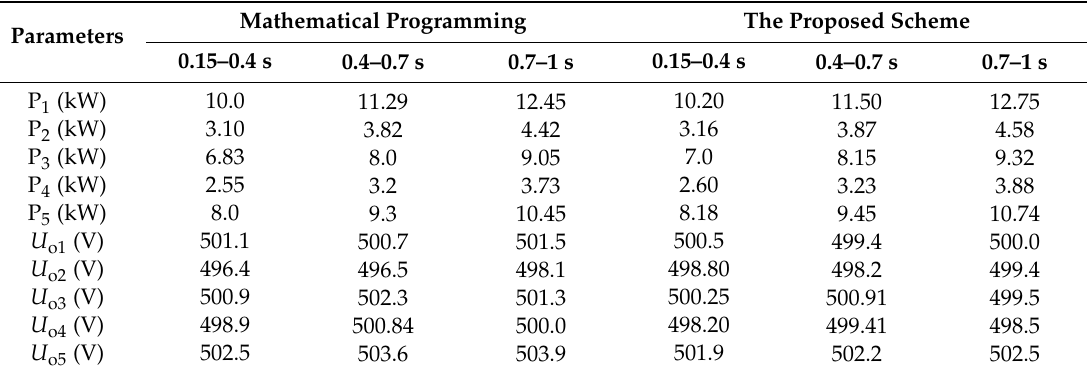
Table 4. The comparison between the mathematical programming and the proposed